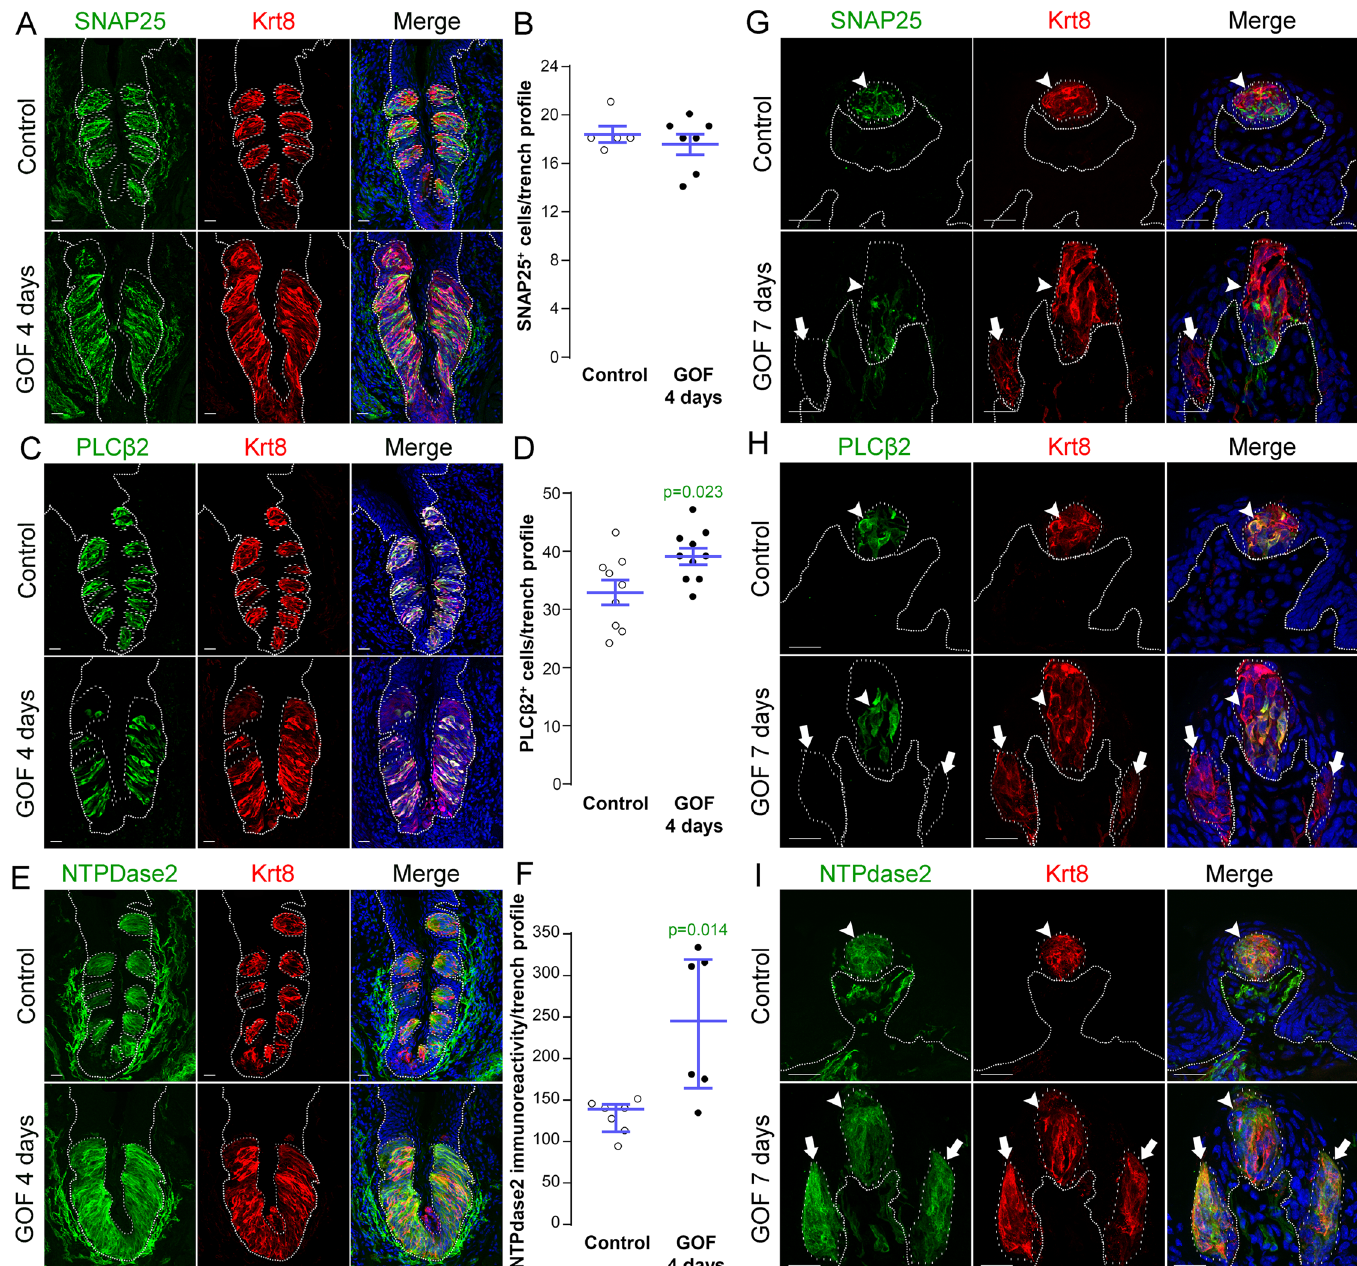
Fig 4. Stabilization of β -catenin in Krt5 + progenitors induces primarily Type I cell differentiation in CVP, FFP and anterior lingual epithelium. A , B. SNAP25 + Type III taste cells (green) were present in comparable numbers in the CVP of control and mutant mice fed dox chow for 4 days. Note that CVP innervation is also SNAP25 + (green) (Yang et al., 2000). C , D . PLC β 2 + Type II cells (green) were slightly increased in mutant CVP compared to controls. E , F . NTPdase2 + Type I cells (green) cannot be counted (see text), and thus were quantified via measurement of NTPdase2 corrected fluorescence intensity, revealing a 2-fold increase in NTPdase2 + signal in mutant compared to control CVP, accounting for the majority of expanded Krt8 + cells (red in all panels). G . In the anterior tongue of mice fed doxycycline chow for 7 days, endogenous Krt8 + taste buds within FFP (red, white arrowhead) contained SNAP25 + Type III cells (green), while ectopic Krt8 + taste buds (red, white arrow) were devoid of SNAP25 + cells. H . Endogenous FF taste buds house numerous PLC β 2 + Type II taste cells (green, white arrowhead), while ectopic PLC β 2 + cells were not detected in ectopic taste buds ( * indicates a PLC β 2-negative ectopic taste bud). I . Ectopic taste buds within FFP of mutants (white arrows), like endogenous FF taste buds (white arrowhead) were always NTPdase2 + (green). Nuclei were counterstained with DRAQ5 in blue. Representative stack images are made of 14 compressed 0.75 μ m-thick optical sections. N = 3 control and 3 mutant mice. B , D : Student ’ s t-test; F : Mann and Whitney test. Data are represented as a scatter plot (individual symbols), and mean ± SEM (blue bars), except F (median with interquartile range). Dotted line delineates the basement membrane. Scale bars = 20 μ m.